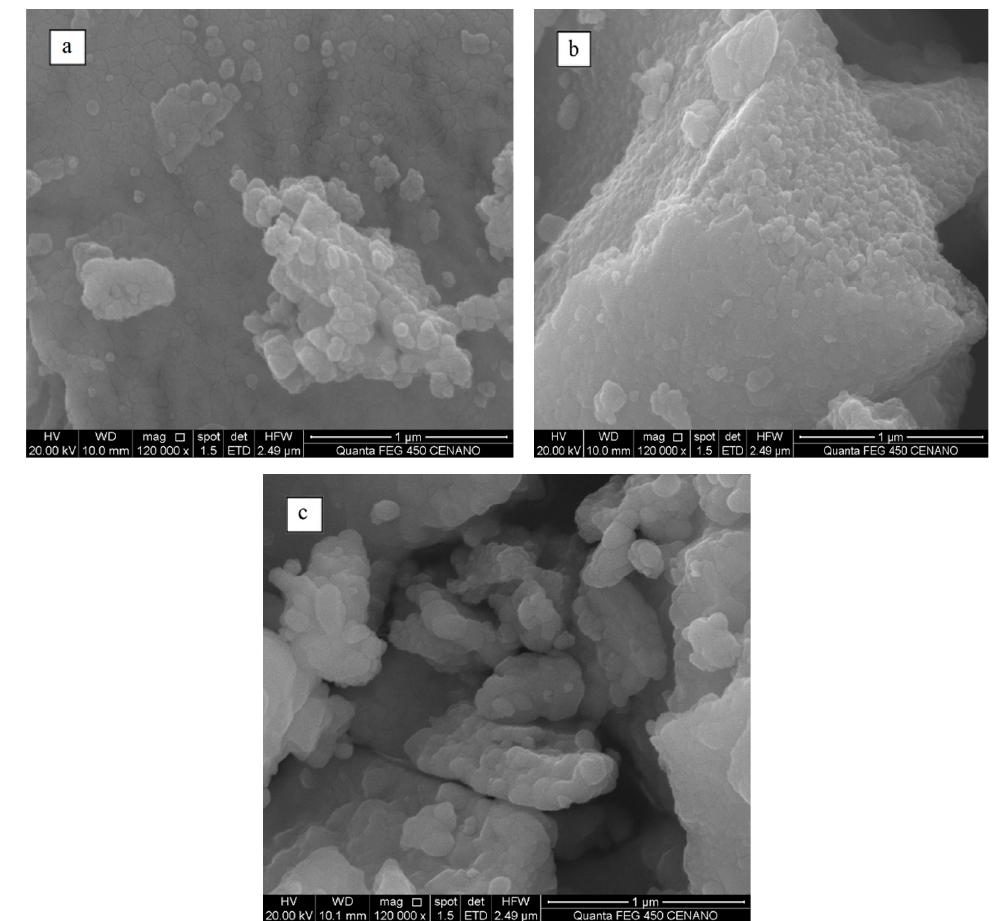
Figure 2. FEG-SEM images of ( a ) Sample 1, ( b ) Sample 2, and ( c ) Sample 3.